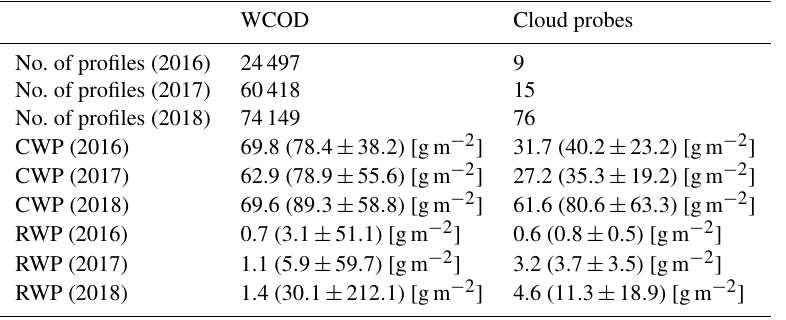
Table 2. Summary of median, mean, and standard deviation values of CWP and RWP statistics from the WCOD retrieval and cloud probe datasets. The mean and 1 σ CWP or RWP are given in parentheses. The top three rows include the number of WCOD-only profiles that were collocated to the in situ cloud probe data. The collocation procedure is described in the text.